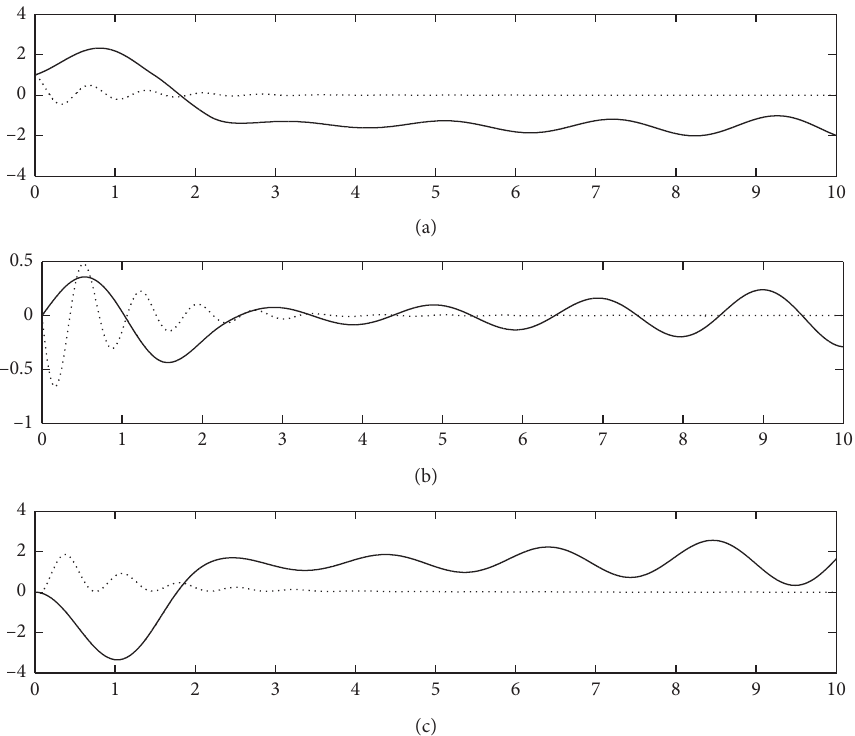
Figure 7: Synchronization of continuous-time chaotic system with (a) x